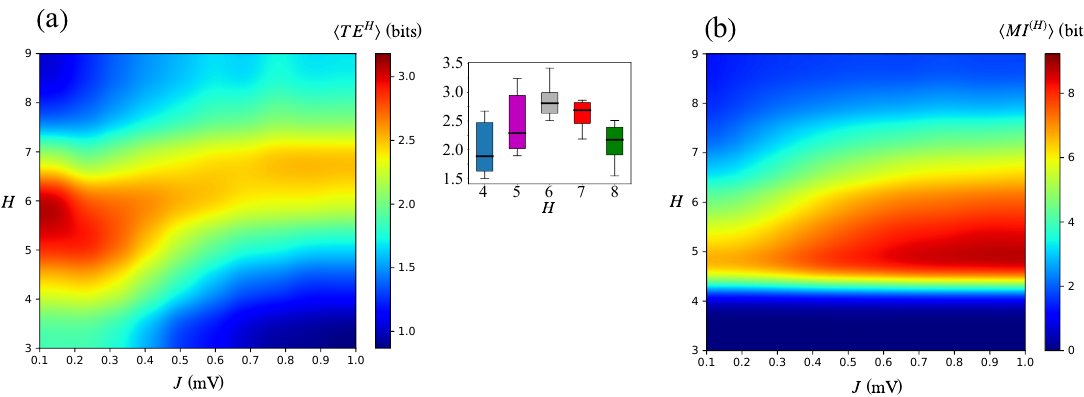
Figure 7. Transfer entropy and mutual information among modules. ( a ) Transfer entropy evaluated among modules (cid:104) TE ( H ) (cid:105) in the two-dimensional diagram where the ordinate represents the hierarchical level H and the abscissa represents the synaptic strength J . Inset: boxplots of (cid:104) TE ( H ) (cid:105) for fixed values of H . ( b ) Mutual information among modules (cid:104) MI ( H ) (cid:105) in the same J - H